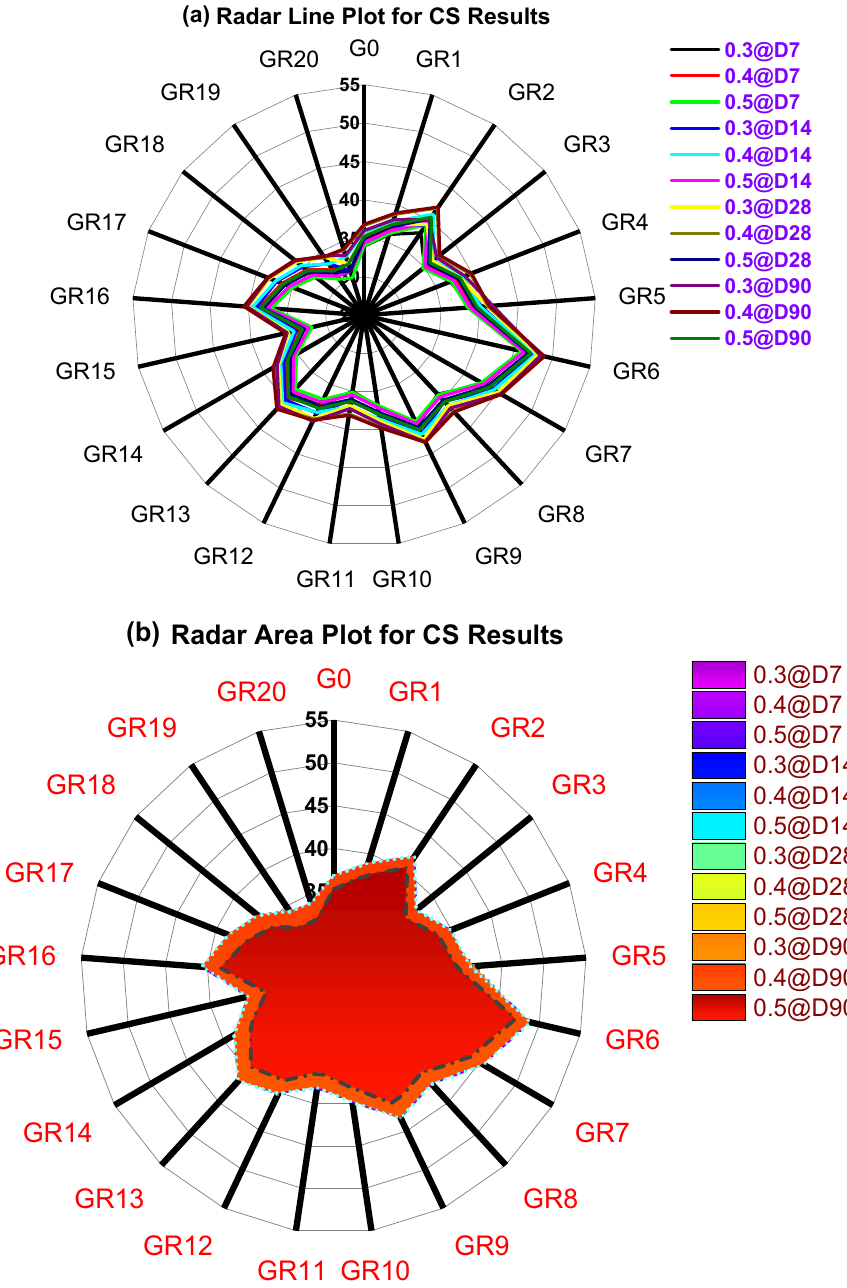
Figure 13. Radar plot for various CS results: ( a ) radar line plot and ( b ) radar area plot. Figure 14 shows the principal components plot for CS tested for 7, 28, and 90 days as D, C, and B components, respectively. GR6 shows the maximum principal component compared with other mixes. The B line indicates that the maximum CS value was obtained for 90 days of testing. The correlation matrix for B was 0.9875. Similarly, for C and D, the values were 0.9964 and 0.99, respectively. The correlation matrix indicates the regression (R2) of all the CS results. On average, CS values had a regression of 0.99.